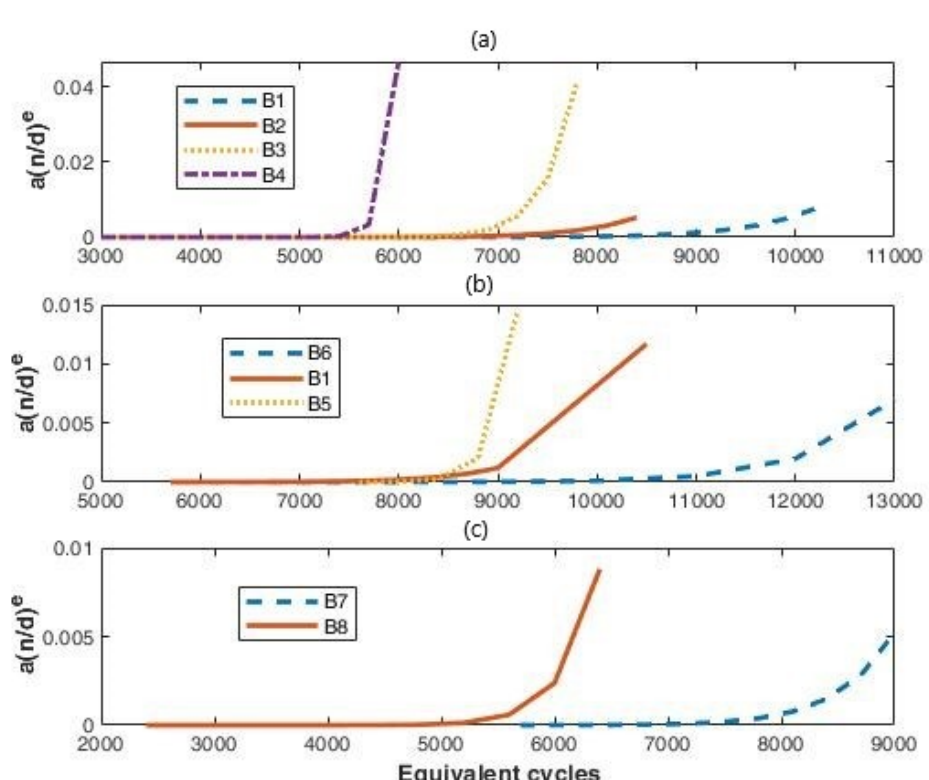
Figure 7. Curves for the exponential term of the transition matrix (8), as a function of the equivalent cycles and for different cells: ( a ) comparison among cells from number 1 to 4; ( b ) comparison among cells number 6, 1 and 5; ( c ) comparison between cell number 7 and cell number 8.